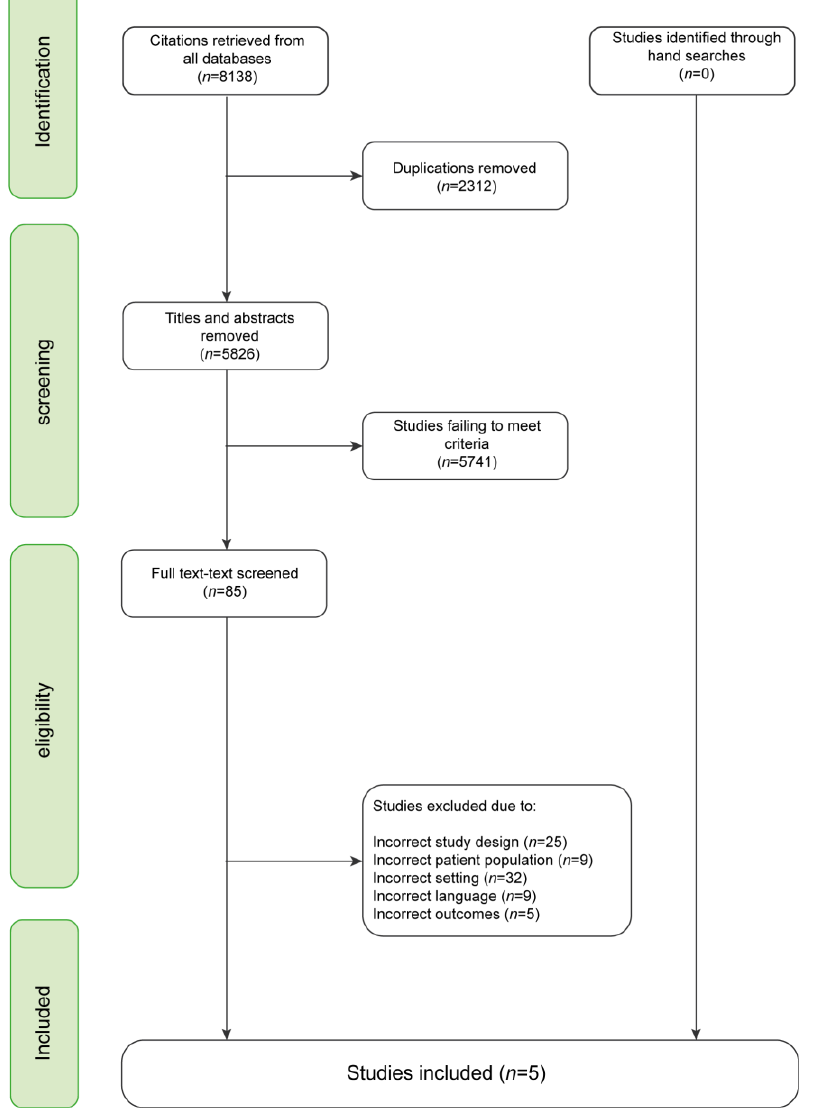
Figure 1. PRISMA flow diagram.